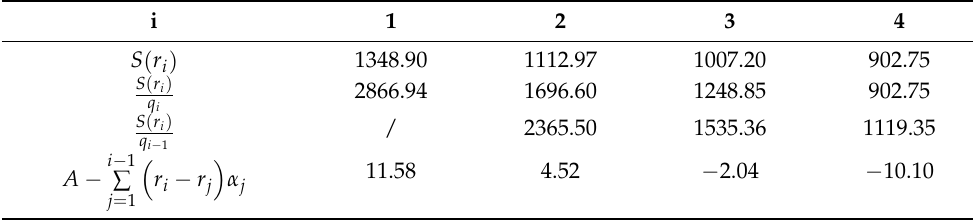
Table 1. Numerical